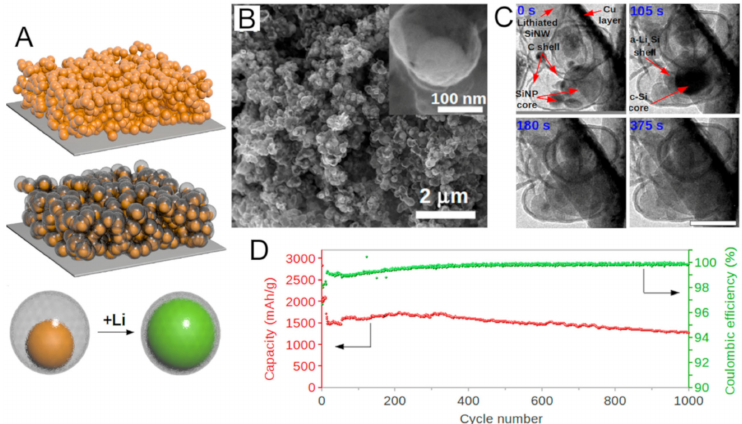
Figure 4. Si@C yolk–shell nanostructure. ( A ) Comparison of a conventional slurry coated